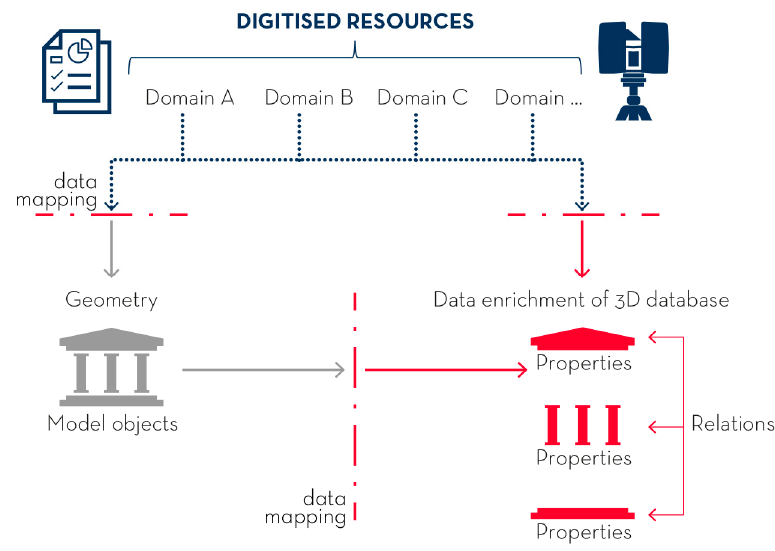
Figure 2. Workflow to develop an HBIM model based on external digitised resources. The external data from different knowledge domains are mapped and flown to the parallel construction of 3D geometries and the corresponding HBIM objects and information (properties and relations).